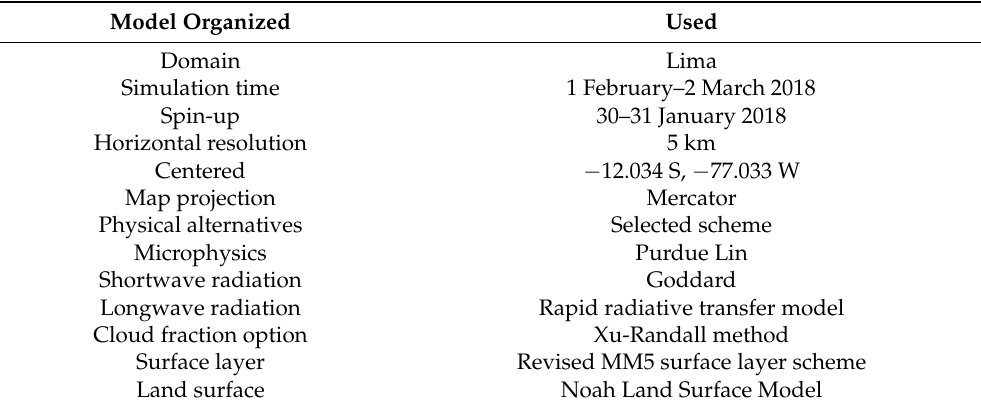
Table 1. Different types of parameterizations selected for the control case